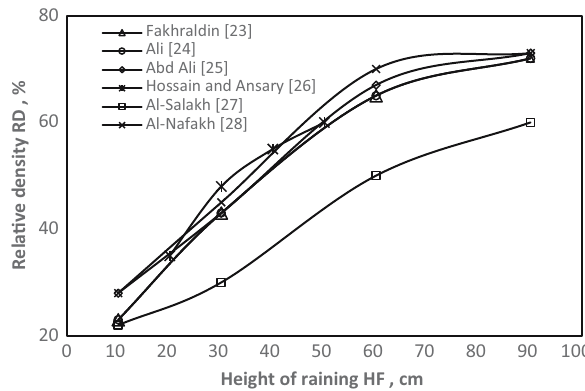
Figure 1: Variation of RD and HF in raining sand method from dif - ferent